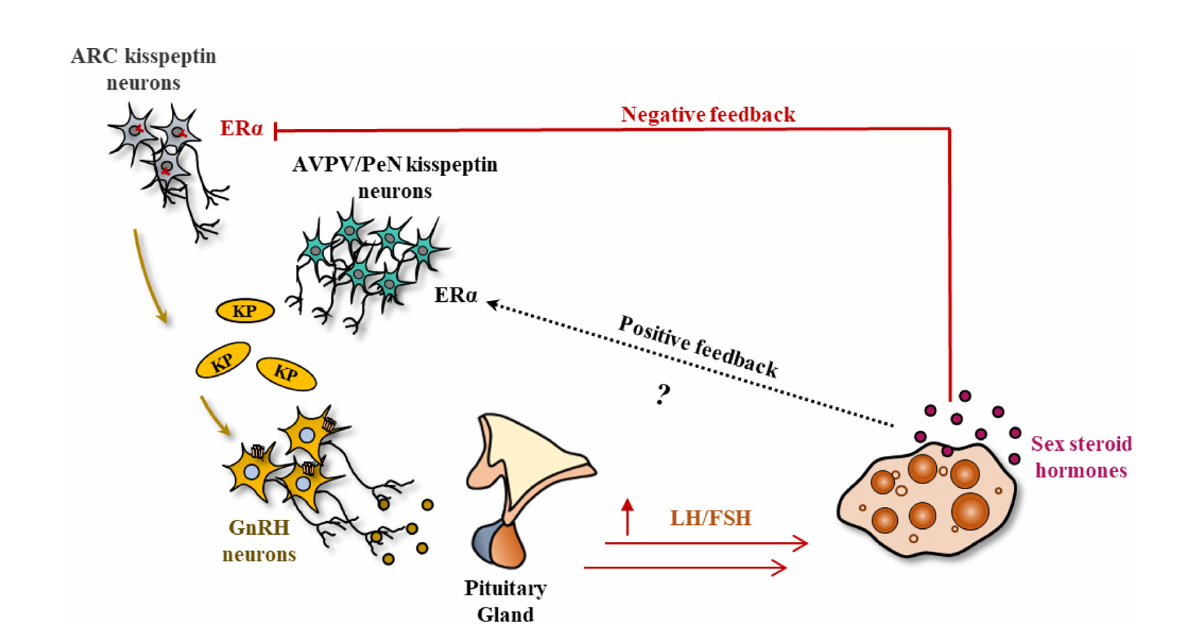
FIGURE 7 Polycystic ovary syndrome. Polycystic ovary syndrome (PCOS) is caused by increased levels of gonadotropins (GPNs, LH/FSH) due to the overstimulation by hypothalamic kisspeptins (KPs). Although the KP-response from the ARC nucleus is increased, it is suspected that PCOS lacks the estrogen induced KP surge from the PeN/AVPV nucleus required for generating the preovulatory GPN surge (unlike Figure 2). Lack of the preovulatory GPN surge in PCOS leads to a lack of follicle maturation and a failure of